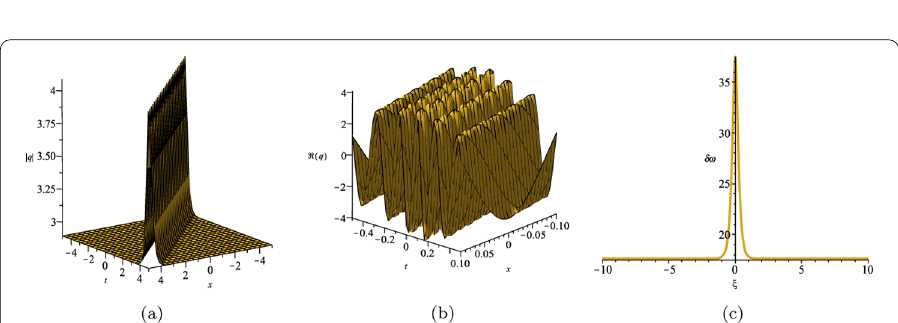
Figure 3 Chirped bright soliton solution (25) with a 1 = 2, a 2 = 4, b = 2, α = 2, λ = 6, μ = 1, ν = 1, σ = 1, Ω = –3. ( a ) Modulus. ( b ) Real part. ( c ) Corresponding